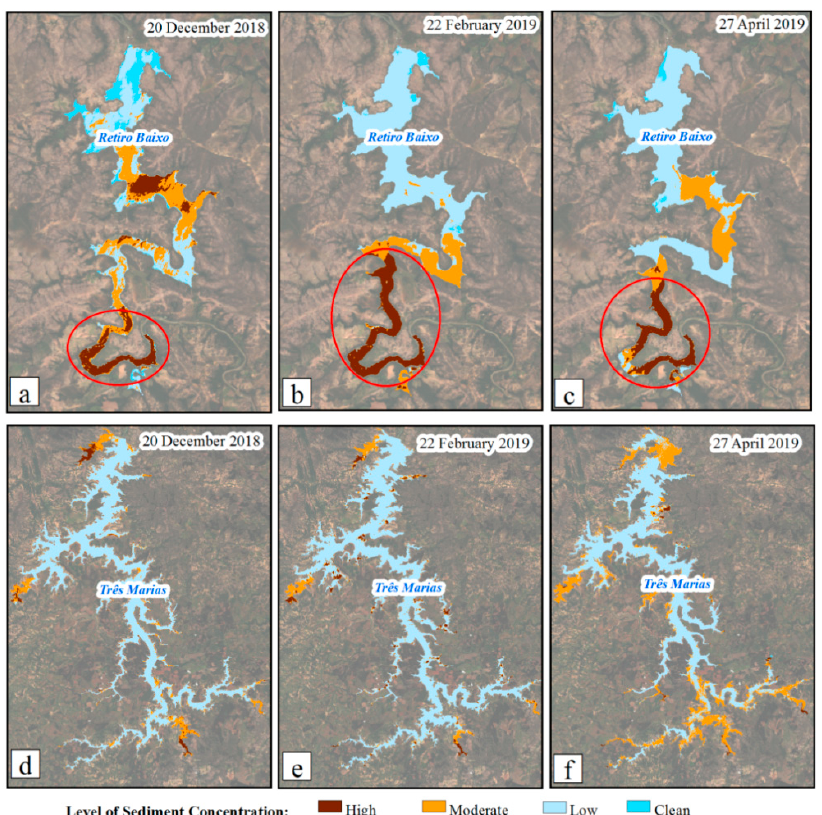
Figure 10. Level of sediment concentration of Retiro Baixo and Três Marias. (a) Level of sediment concentration of Retiro Baixo on 20 December 2018; (b) level of sediment concentration of Retiro Baixo on 22 February 2019; (c) level of sediment concentration of Retiro Baixo on 27 April 2019; (d) level of sediment concentration of Três Marias on 20 December 2018; (e) level of sediment concentration of Três Marias on 22 February 2019; (f) level of sediment concentration of Três Marias on 27 April 2019.